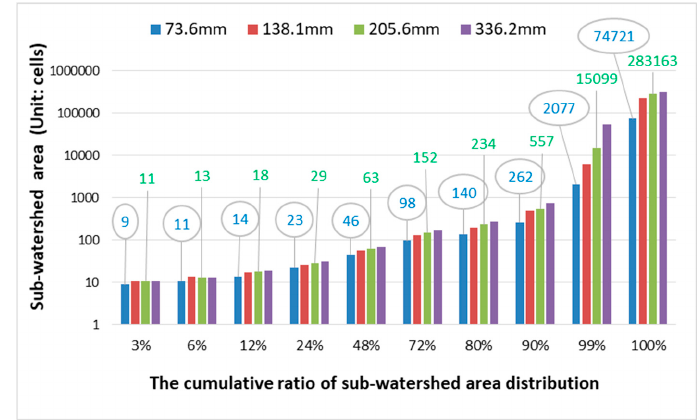
Figure 10. List of parts of the unique values of sub-watershed areas while the value of the cumulative area ratios are approximately {3%, 6%, 12%, 24%, 48%, 72%, 80%, 90%, 99%, and 100%}. The blue, red, green, and purple-colored histograms represent the sub-watersheds delimitated in terms of the four